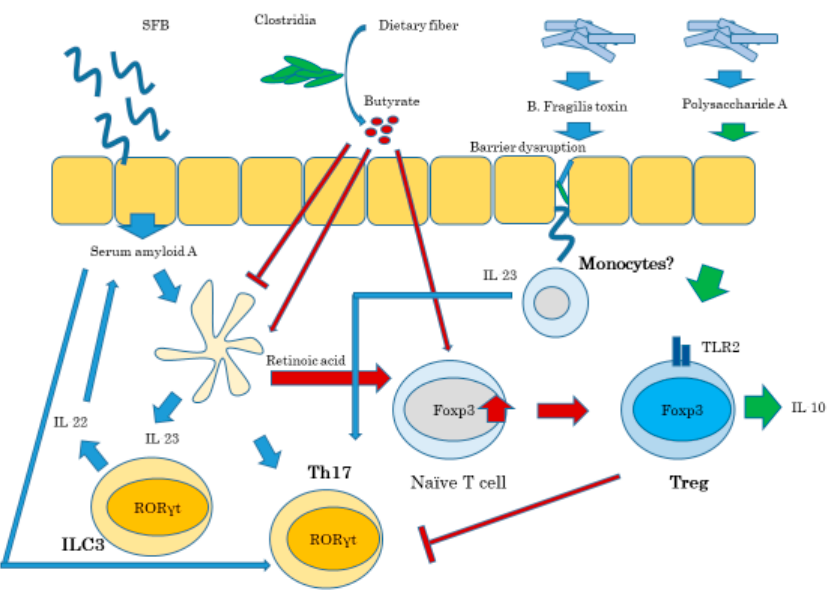
Figure 6. Gut microbiota regulates the balance of Th17 vs. Tregs. Modified from Omenetti S and Pizzaro TT. Frontiers Immuno 2015 [43].